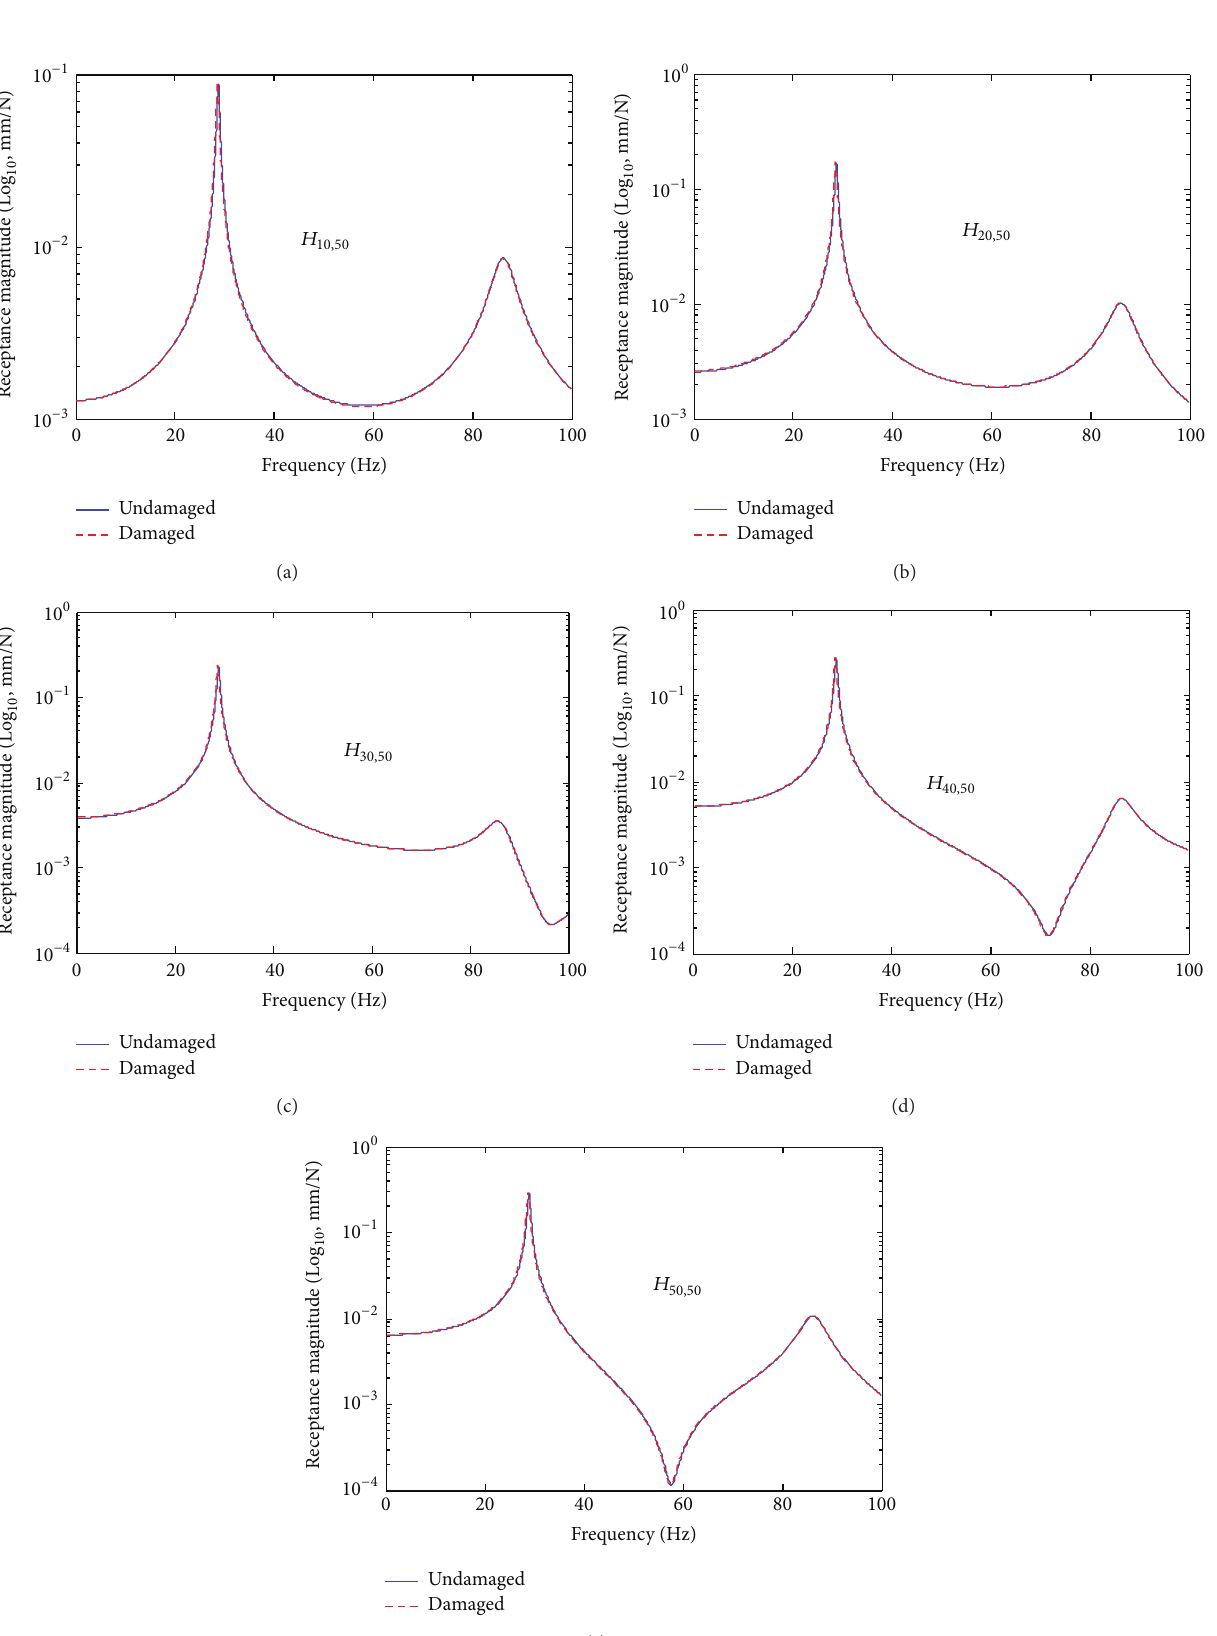
Figure 4: FRF curves: (a) 𝐻 10,50 , (b) 𝐻 20,50 , (c) 𝐻 30,50 , (d) 𝐻 40,50 , and (e) 𝐻 50,50